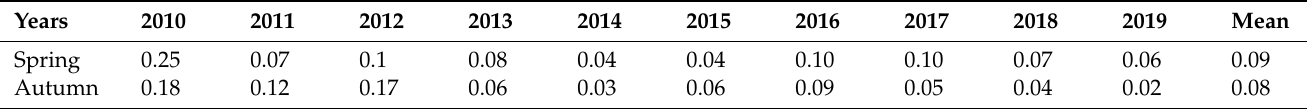
Table A2. Dissimilarity of spring and autumn between 2020 and other years.